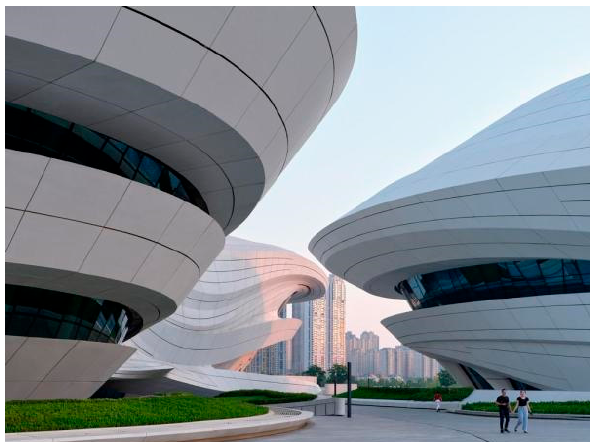
Figure 16. Façade of Changsha Meixihu International Contemporary Art Museum viewed from the main square; the photograph source: the official website of (zaha-hadid.com accessed on 8 December 2020) [34].